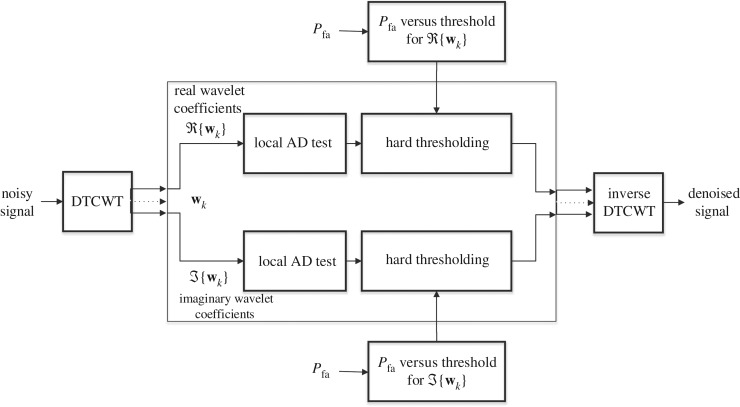
Block diagram of the proposed denoising method.